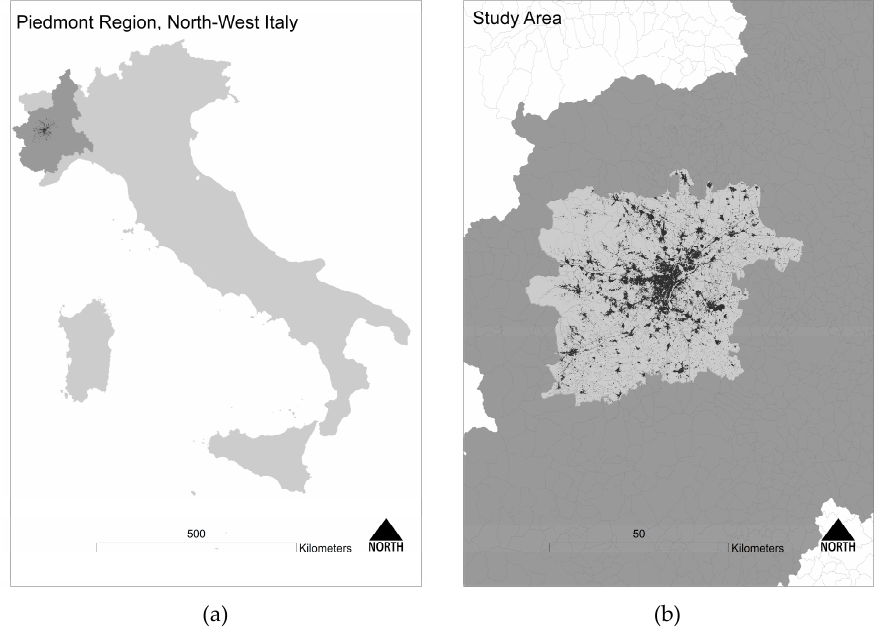
Figure 1. The context of study. ( a ) The location of the Piedmont region in Italy and ( b ) the context of study (in lighter grey, the catchment area).